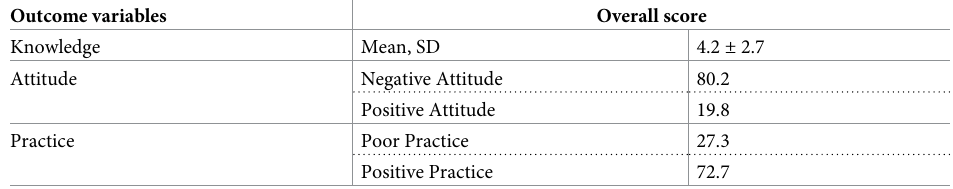
Table 7. Summary of the study outcome